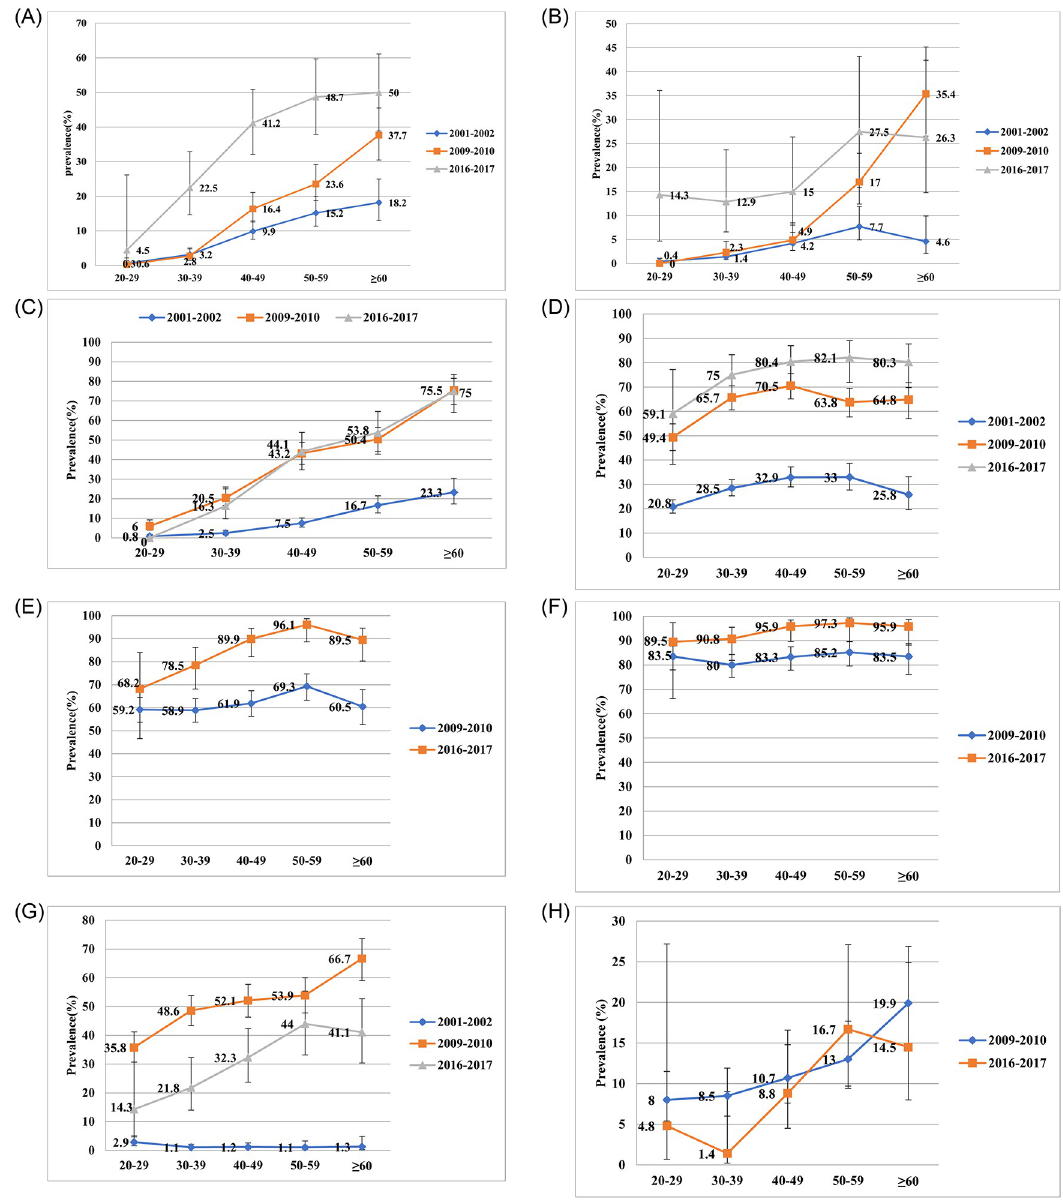
Fig 1. A: Age-specific prevalence of Diabetes. Diabetes was defined as FPG � 126mg/dl. B: Age-specific prevalence of Pre-diabetes. Pre-diabetes defined as FPG:110–125 mg/dl. C: Age-specific prevalence of hypertension. Hypertension was defined as if the systolic blood pressure was � 140mm Hg and/or diastolic blood pressure � 90mm Hg or, already diagnosed by a physician or taking any antihypertensive medication. D: Age-specific prevalence of Overweight/obese. Overweight/obesity as defined as BMI � 23 kg/m 2 . E: Age-specific prevalence of Central obesity. Central obesity was defined as waist circumference � 90cm and � 80cm in males and females. F: Age-specific prevalence of Dyslipidaemia. Dyslipidaemia was defined as cholesterol > 200mg/dl or triglyceride > 150 mg/dl or LDL > . G: Age-specific prevalence of tobacco addiction. H: Age-specific prevalence of alcohol addiction.